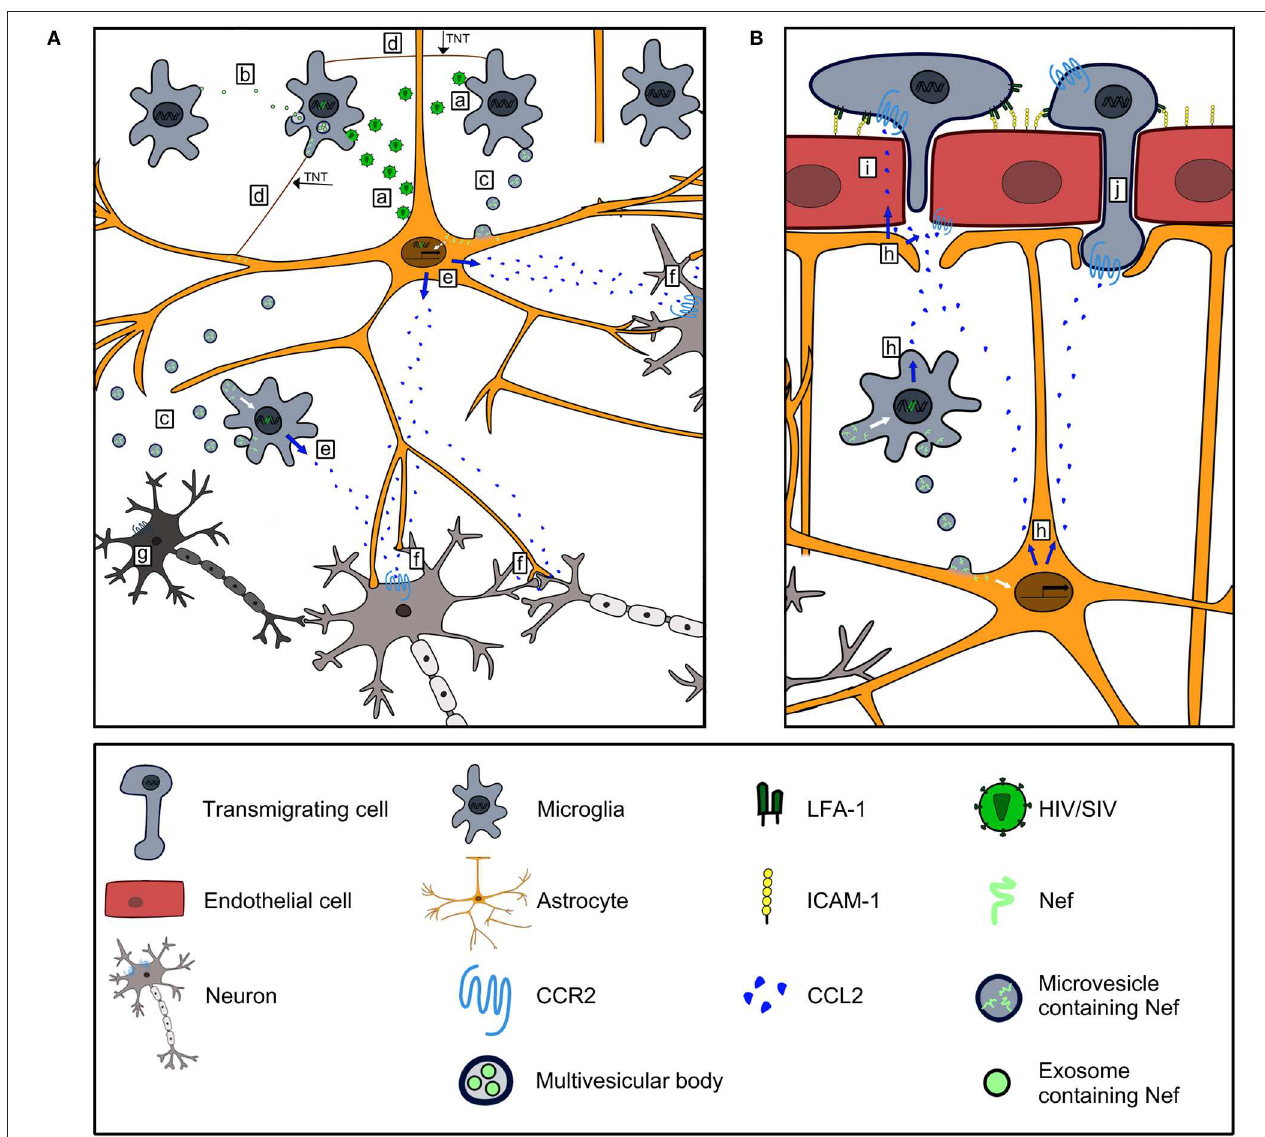
FIGURE 2 | Contribution of Nef-induced CCL2 expression to HIV/SIV neurovirulence. (A) HIV/SIV-infected microglia and astrocytes infect uninfected microglia and astrocytes (a), and disseminate Nef via exosomes (b), microvesicles (c) and TNTs (d) to uninfected cells. Nef harboring astrocytes and microglia express CCL2 (e). CCL2 stimulates CCR2 signaling in neurons leading to their dysfunction (f) and death (g). (B) CCL2 produced by Nef harboring astrocytes and microglia (h) is transported transcellularly across BMEC (136) to act on CCR2 + cells along the luminal side of the BBB (i). CCL2 binds to CCR2 on BMEC and mediates disruption of endothelial junctions (86, 87) to foster invasion of CCR2 + cells into the brain (j).